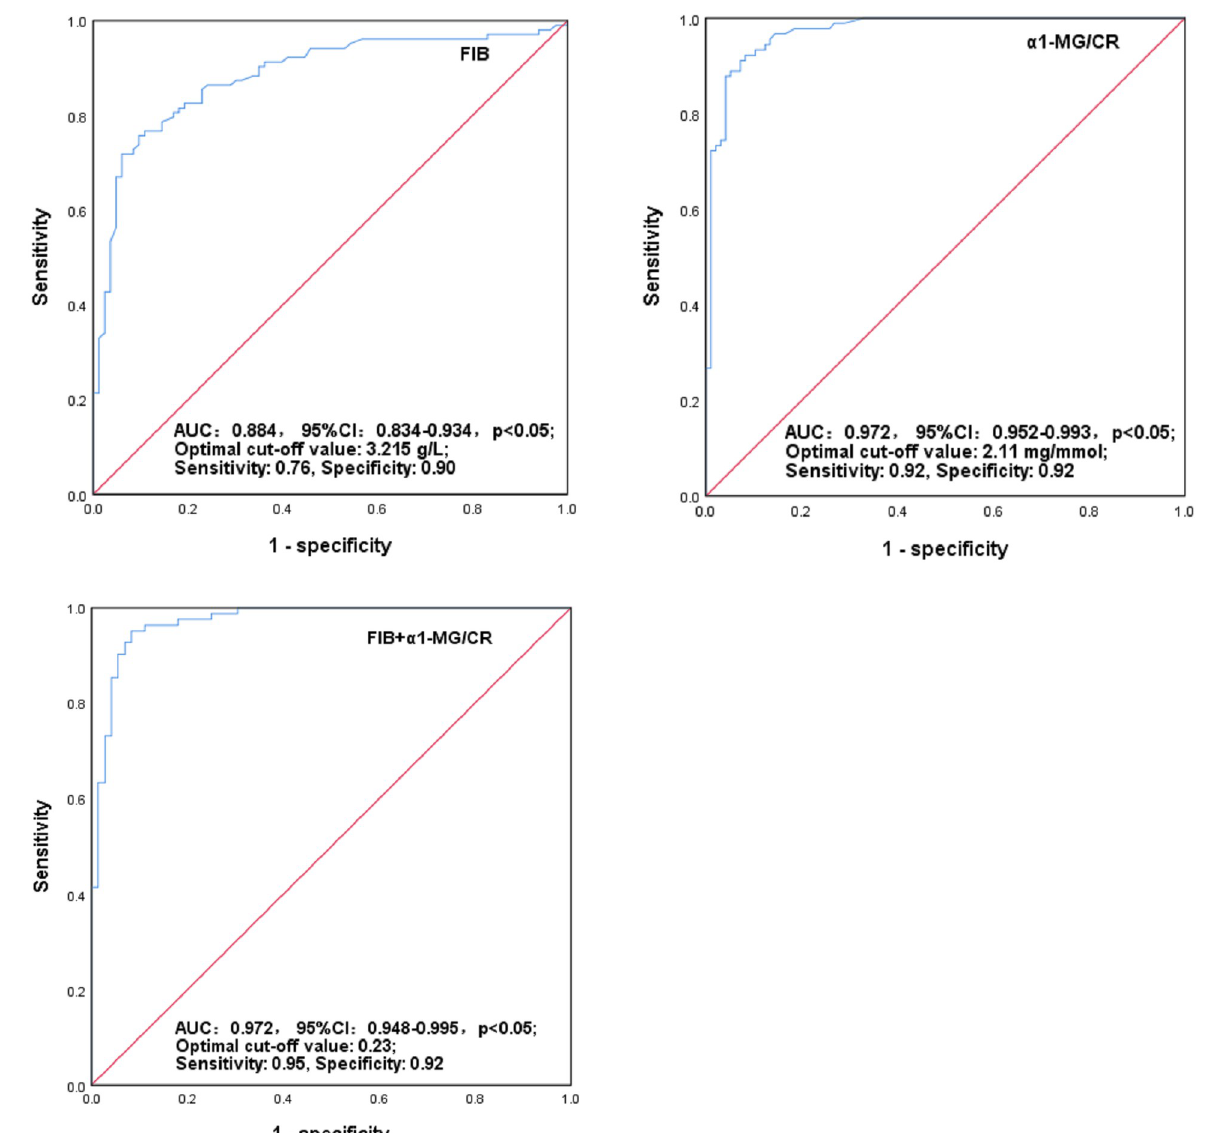
Fig 1. ROC curves of joint FIB and α 1-MG/CR in identifying patients with DKD. Curve for joint FIB and α 1-MG/CR was constructed by using the prediction probability. DKD: diabetic kidney disease; T2D: type 2 diabetes; FIB: fibrinogen; MG: microglobulin; CR: creatinine; ROC: receiver operating characteristic. AUC: area under